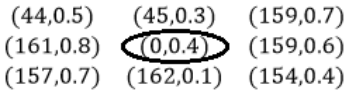
Figure 3. Matrix neighborhood with noise.